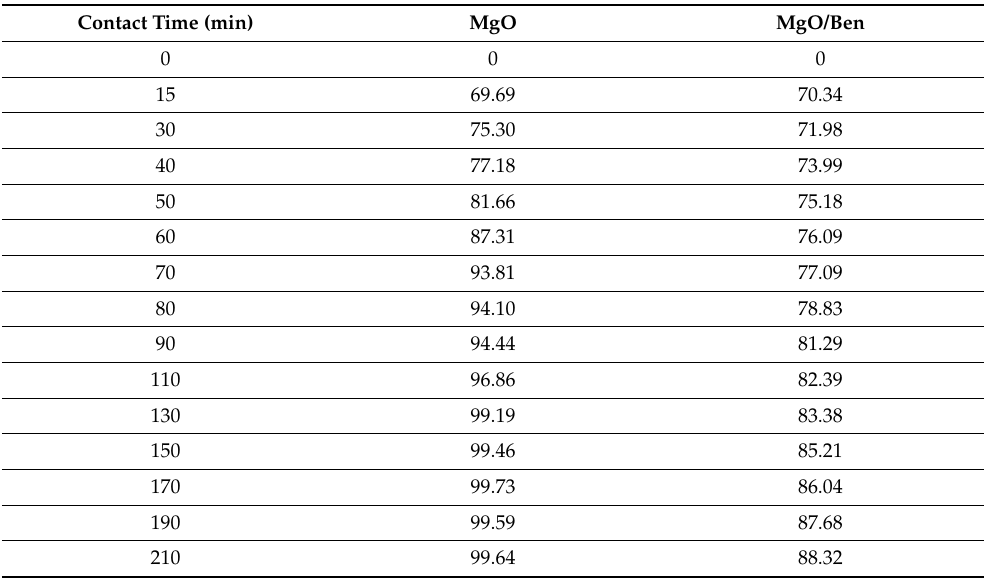
Table 2. Effect of different contact times on the degradation efficiency of CV dye by using MgO NPs and MgO/Ben nanocomposite as a photocatalyst.